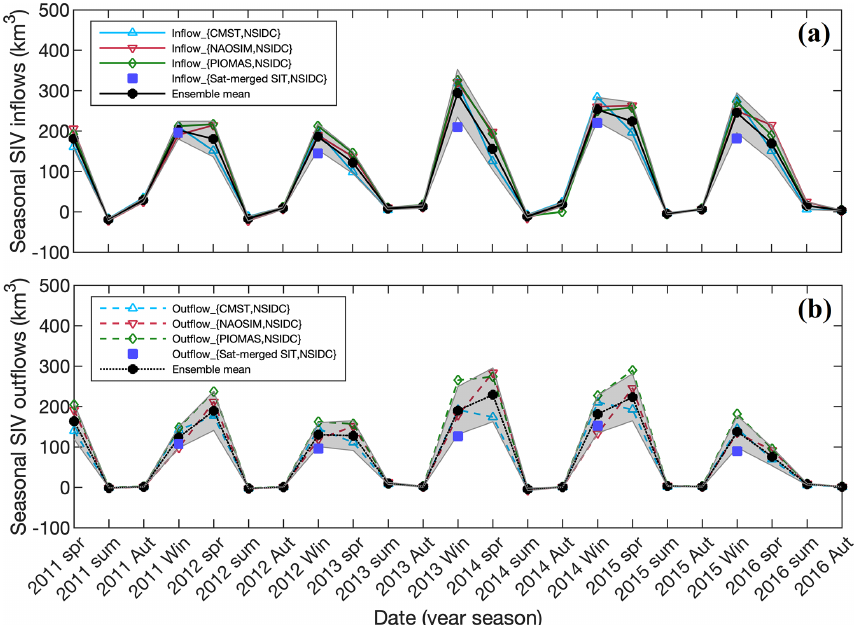
Figure 4. As Fig. 3 but for long-term seasonal evolution of sea-ice inflows and outflows. Note that these blue squares represent the SIV fluxes from Sat-merged SIT and NSIDC